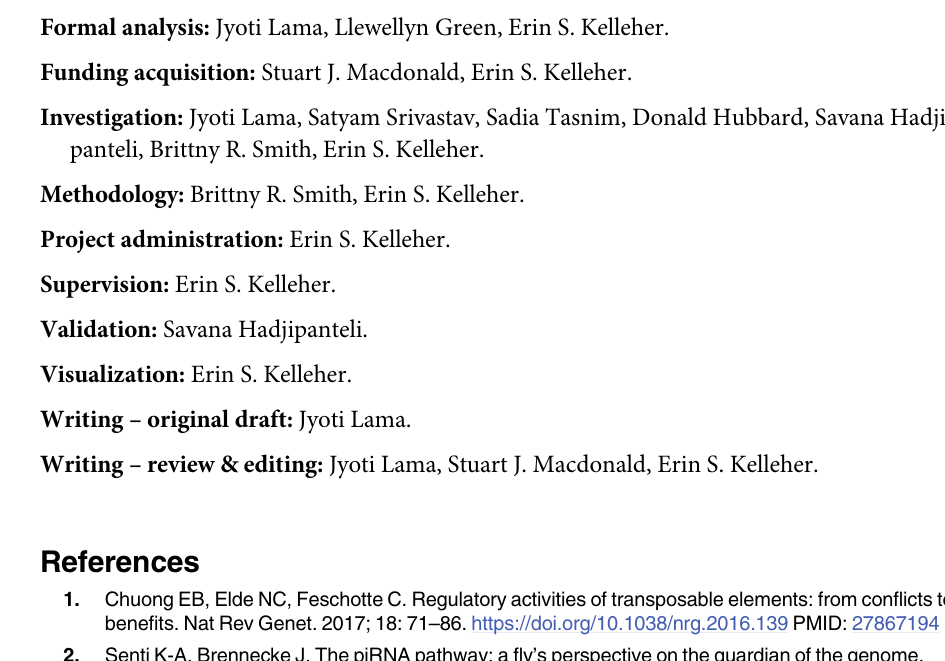
S15 Table. PCA analysis of piRNA cluster expression data of background-matched recom- binant inbred lines. S16 Table. Uniquely mapping read coverage of piRNAs from sterile and fertile ovaries for both plus and minus strand of differentially active piRNA clusters in QTL-3d. S17 Table. Incidence of ovarian atrophy among in F1 females from crosses between iso- genic Fertile/Sterile lines and Harwich males. S18 Table. Fertility of F1 females from crosses between isogenic tolerant/sensitive lines and Harwich males. S19 Table. Radiation sensitive of sterile and fertile alleles and controls. S20 Table. Number of novel SNPs and indels in population B RIL genomes. S21 Table. qPCR estimates of P-element derived mRNA abundance in dysgenic ovarian